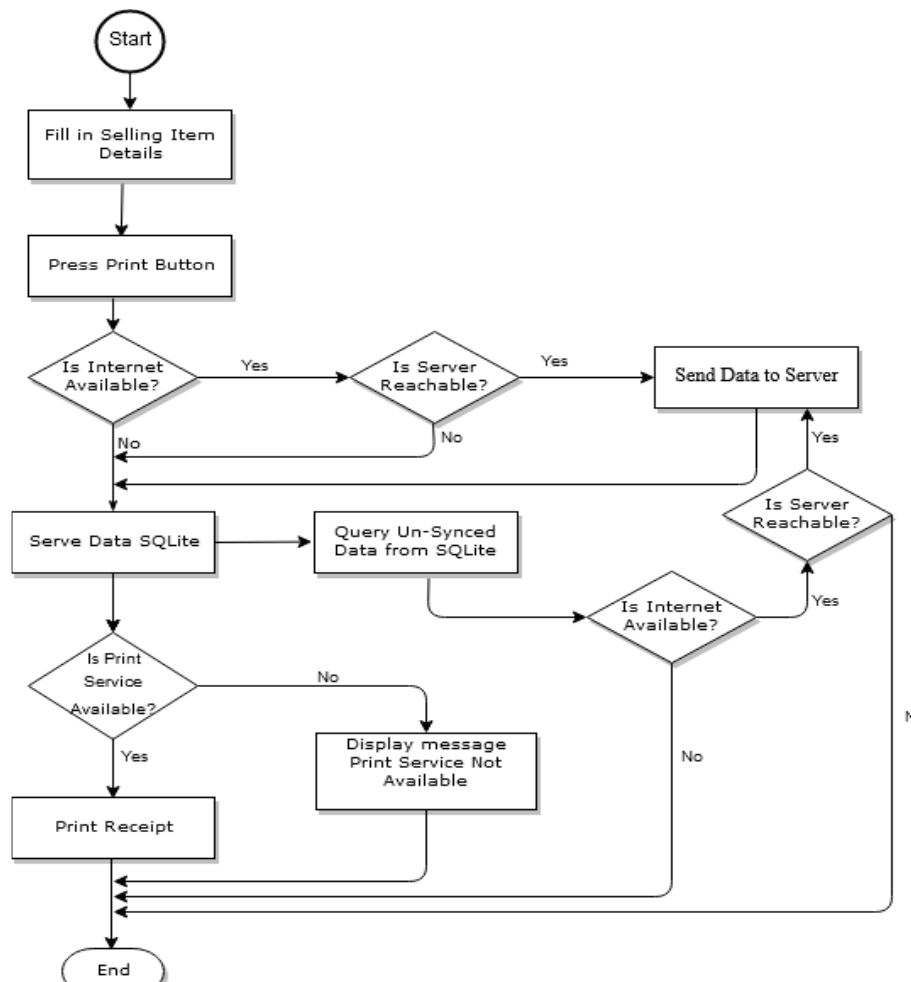
Figure 8. Data transmission logic between EFD machine and